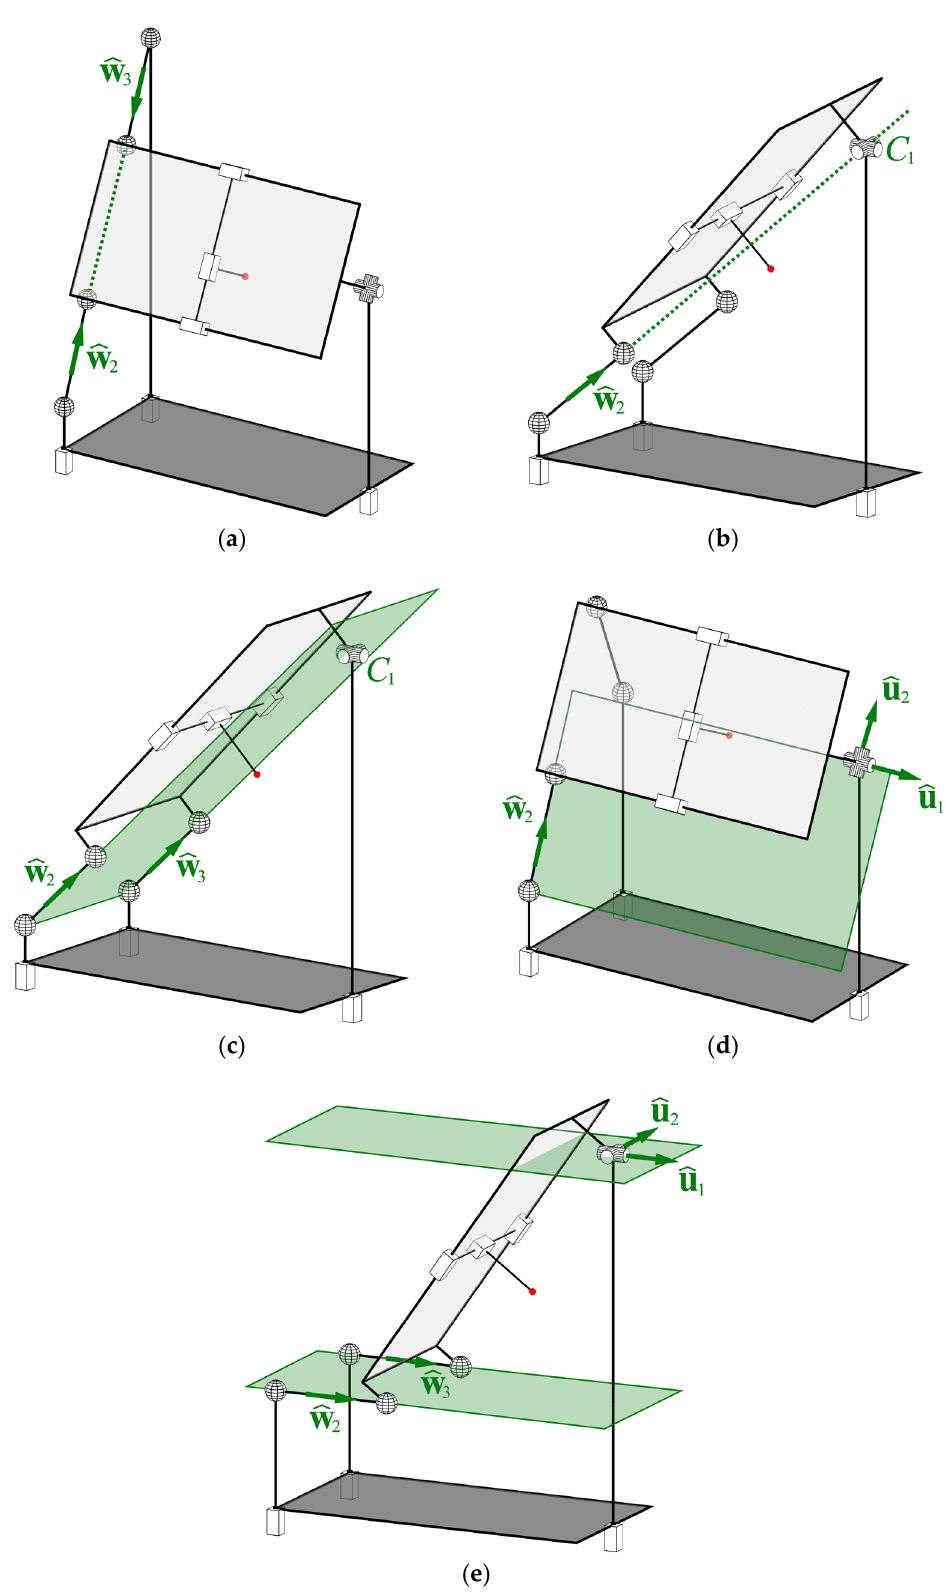
and are collinear; ( b ) passes through ; ( c ) and Figure 8. Parallel singularities: ( a ) Figure 8. Parallel singularities: ( a ) ˆ w 2 and ˆ w 3 are collinear; ( b ) ˆ w 2 passes through C 1 ; ( c ) ˆ w 2 and ˆ w 3 lie in a plane passing through ; ( d ) lie in the spider plane, spanned by and ; ( e ) lie in a plane passing through C 1 ; ( d ) ˆ w 2 lie in the spider plane, spanned by ˆ u 1 and ˆ u 2 ; ( e ) ˆ w 2 and ˆ w 3 𝐰𝐰� 2 𝐰𝐰� 3 𝐰𝐰� 2 𝐰𝐰� 2 𝐶𝐶 1 are parallel and lie in a plane parallel to the spider plane. and are parallel and lie in a plane parallel to the spider 𝐰𝐰� 3 𝐰𝐰� 2 𝐮𝐮� 1 𝐮𝐮� 2 𝐰𝐰� 2 𝐶𝐶 1 𝐰𝐰� 3